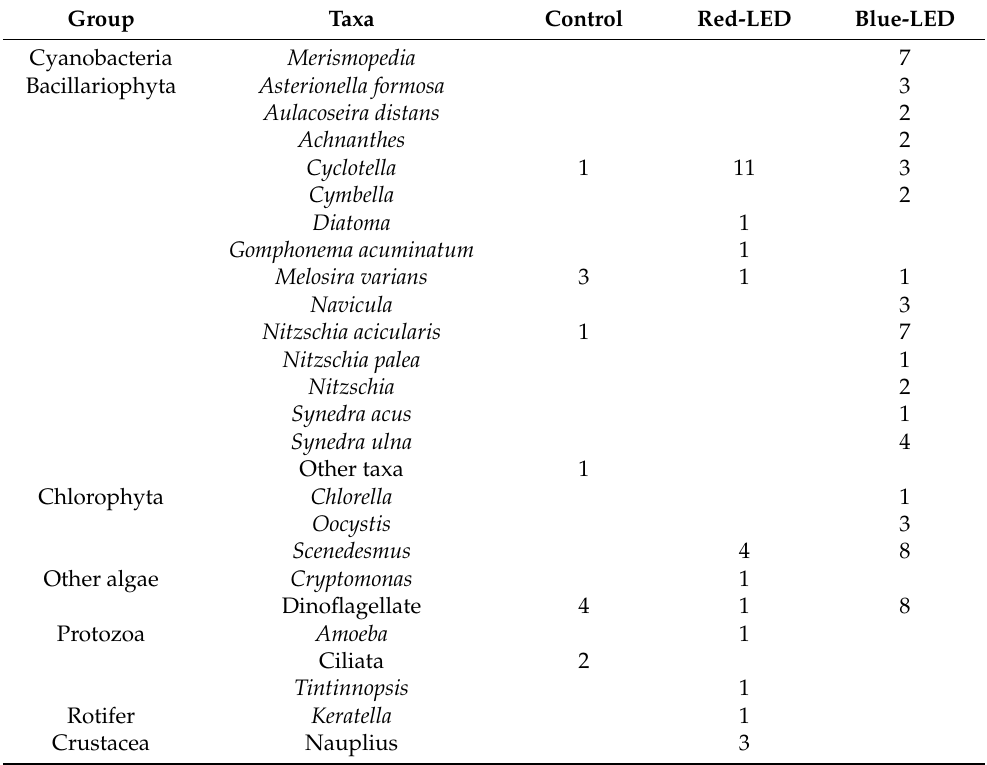
Table A2. Cell abundance (cells 0.1 mL − 1 ) of phytoplankton and zooplankton in water in the three depressions at the end of